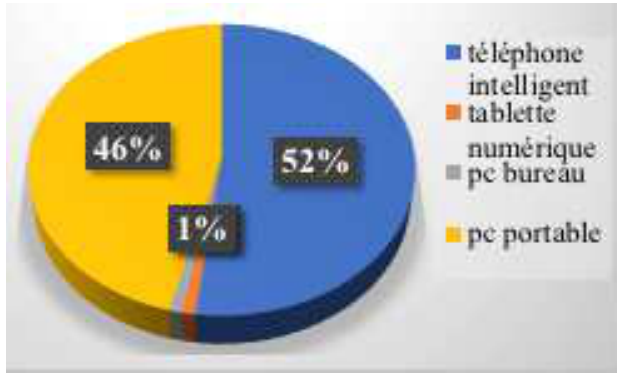
Fig. 3. Proportions d’accès aux dispositifs